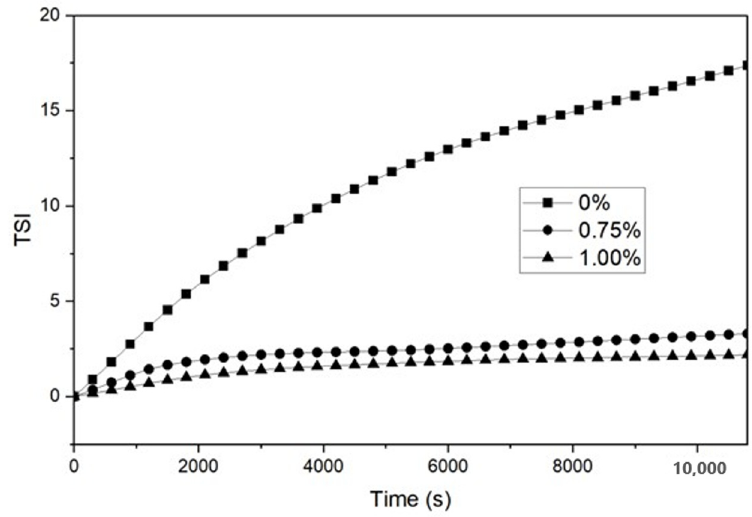
Figure 6. Turbiscan stability index (TSI) of O/W emulsions with the addition of C. olitorius mucilage for 3 h of storage at room temperature.